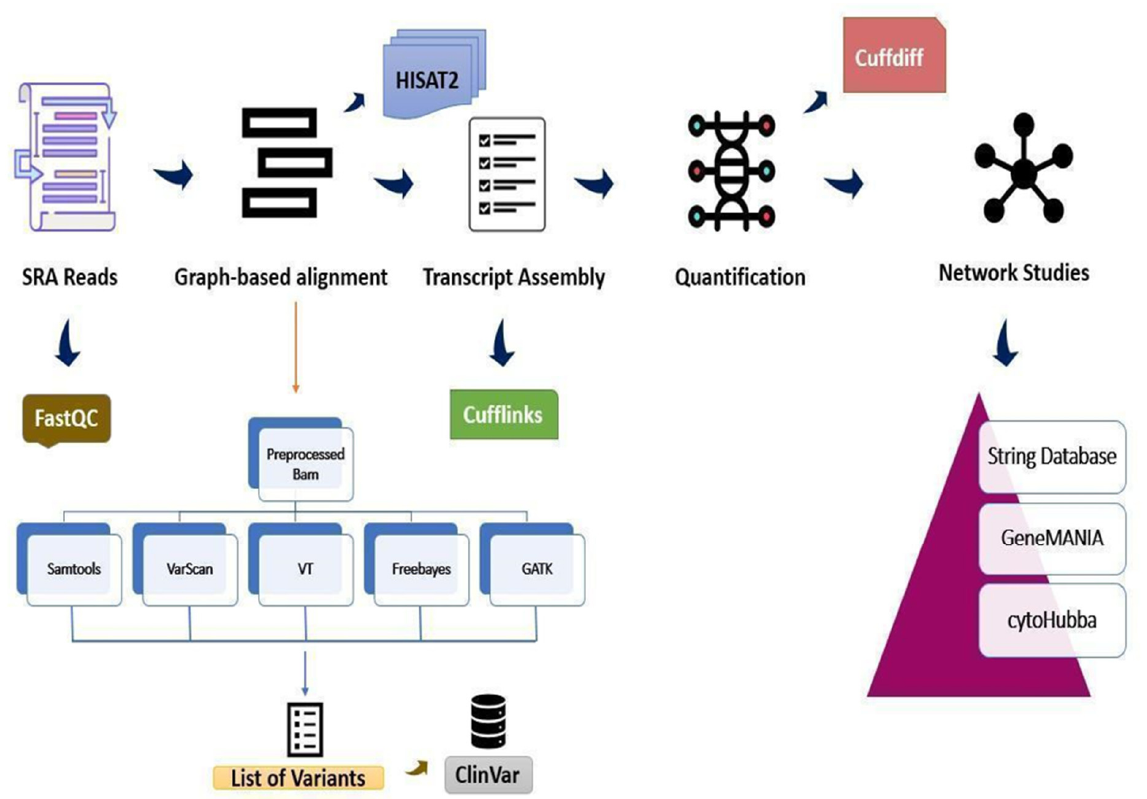
Figure 1. Workflow of the RNA-Seq pipeline. The pipeline for differential gene expression analysis of RNA-Seq data. In the variant calling step, five different approaches, viz . SAMtools, VarScan, Vt, FreeBayes and GATK, were utilized to identify significant SNPs.